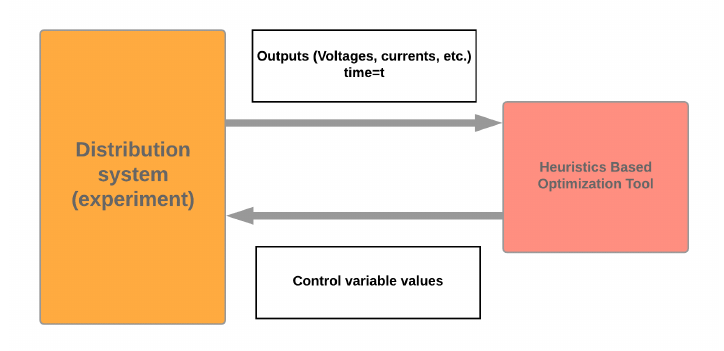
Figure 1. Co-simulation